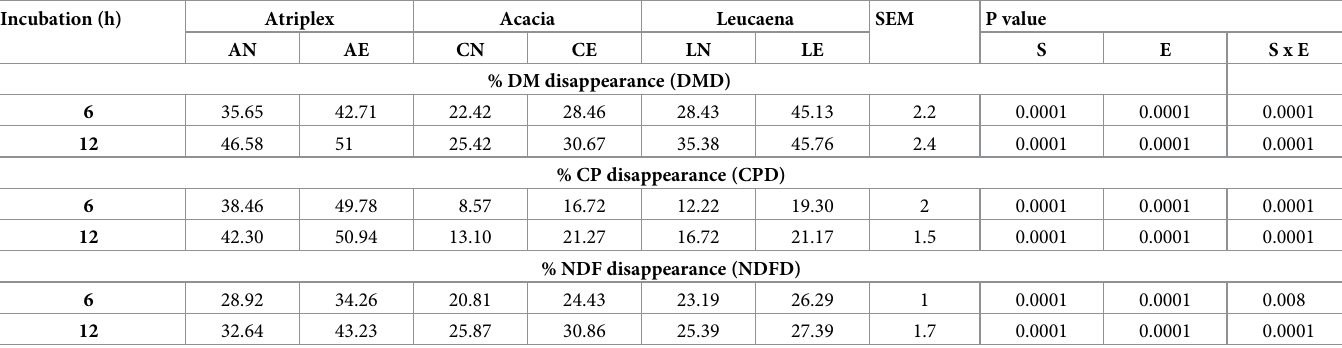
Table 2. Disappearance (%) of dry matter (DMD), crude protein (CPD), neutral detergent fiber (NDFD) at 6 and 12h of incubation for extracted and non-extracted atriplex (AN, AE), acacia (CN, CE), leucaena (LN, LE) in the rumen of camels. Incubation